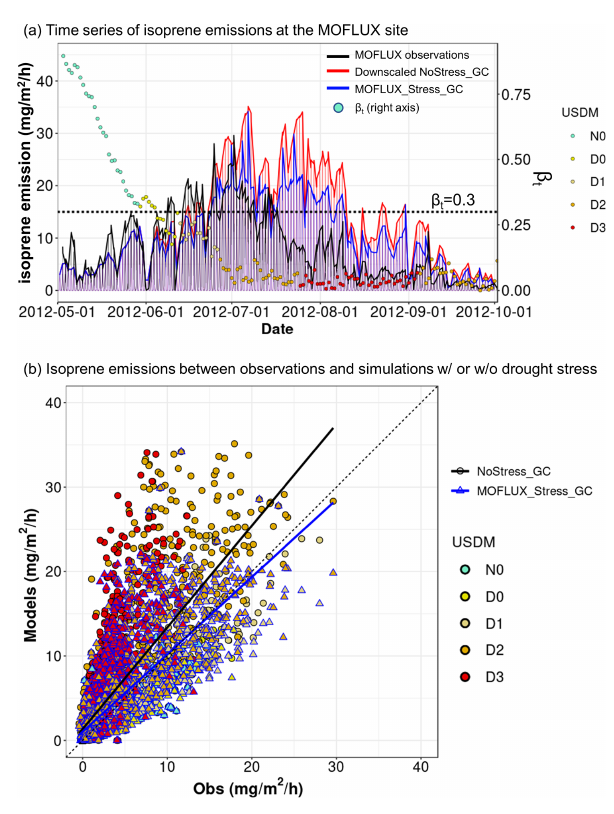
Figure 6. (a) Hourly time series of isoprene emissions at the MOFLUX site from observations (black line) and simulations with (MOFLUX_Stress_GC; blue line) and without (NoStress_GC; red line; after downscaling) drought stress. The dots, color-coded by USDM levels, represent the daily values of β t (right axis). The dashed line indicates the threshold of 0.3. (b) Comparison of iso- prene emissions between observations (Obs) and simulations with (MOFLUX_Stress_GC; blue-bordered triangle) and without (NoS- tress_GC; black-bordered circle) drought